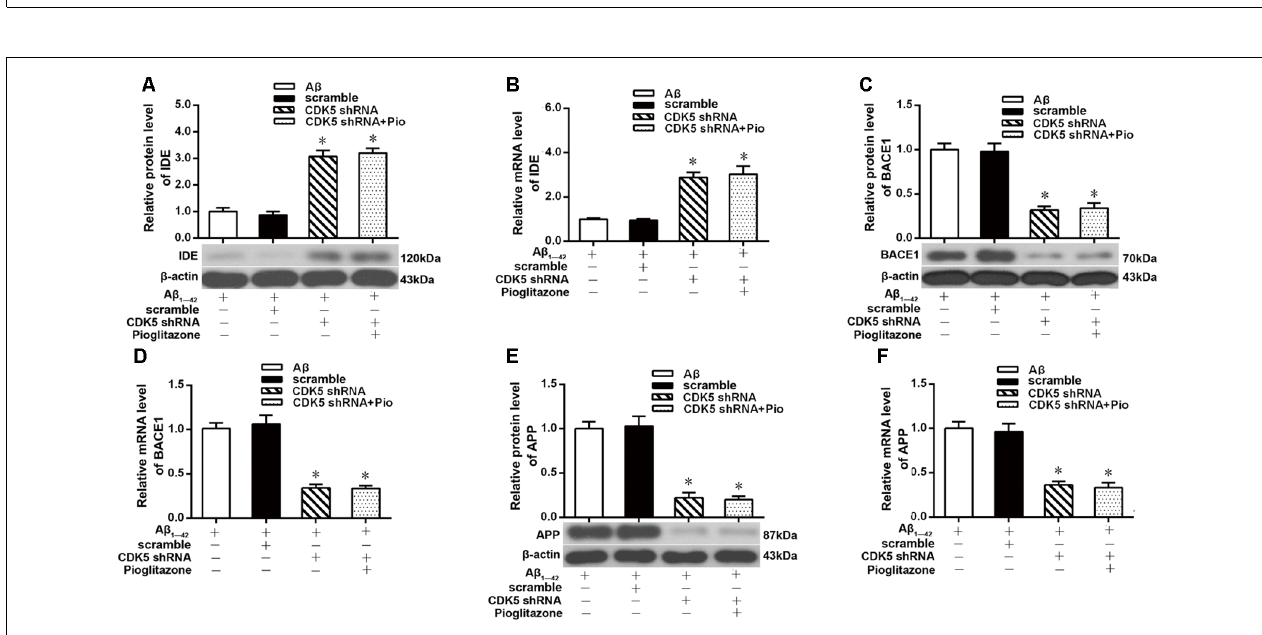
FIGURE 6 | Effects of pioglitazone on PPAR γ target gene expression in AD model neurons after CDK5 silencing. (A) Western blot results for IDE. (B) Real-time PCR results for IDE. (C) Western blot results for BACE1. (D) Real-time PCR results for BACE1. (E) Western blot results for APP. (F) Real-time PCR results for APP. n = 6 wells per group. ∗ P < 0.05 compared to the A β